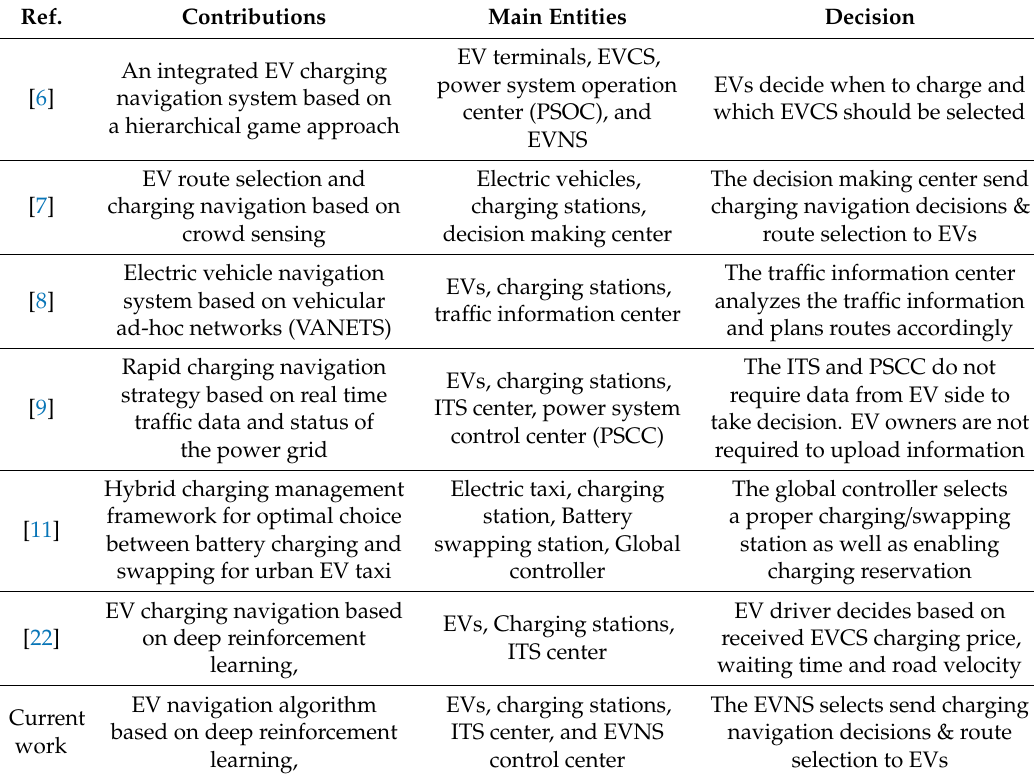
Table 1. Summary of literature review for main entities of electric vehicle navigation system. Ref.